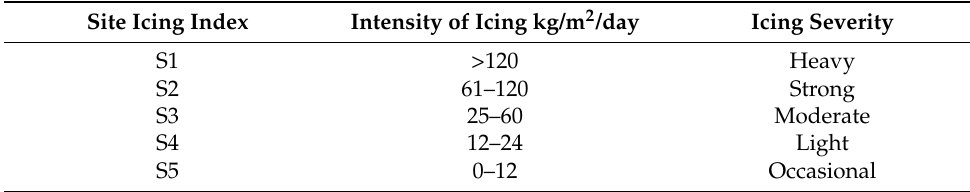
Table 2. Site icing index